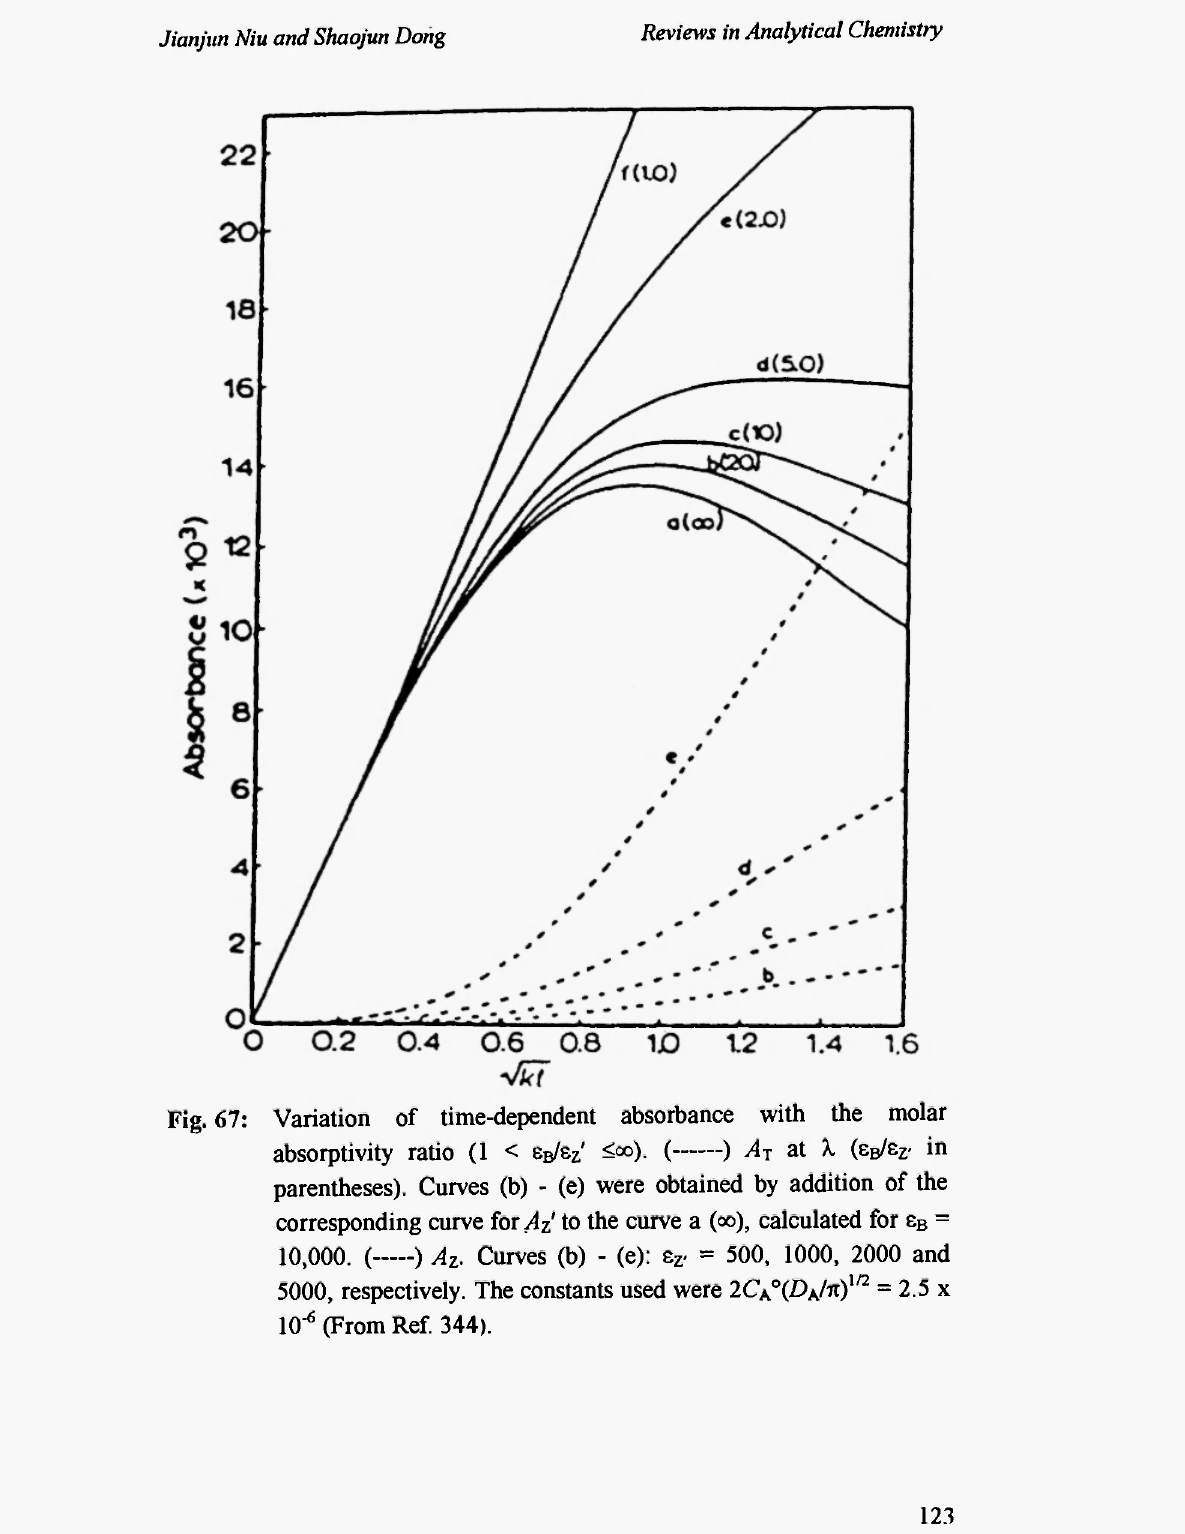
Fig. 67: Variation of time-dependent absorbance with the molar absorptivity ratio (1 < sWe z ' ( ) Α Ί at λ (εβ/ε ζ . in parentheses). Curves (b) - (e) were obtained by addition of the corresponding curve for/lz' to the curve a (oo), calculated for ε Β = 10,000. ( ) A z . Curves (b) - (e): ε ζ . = 500, 1000, 2000 and 5000, respectively. The constants used were 2C A °(D A /n) V2 = 2.5 χ 10" 6 (From Ref.